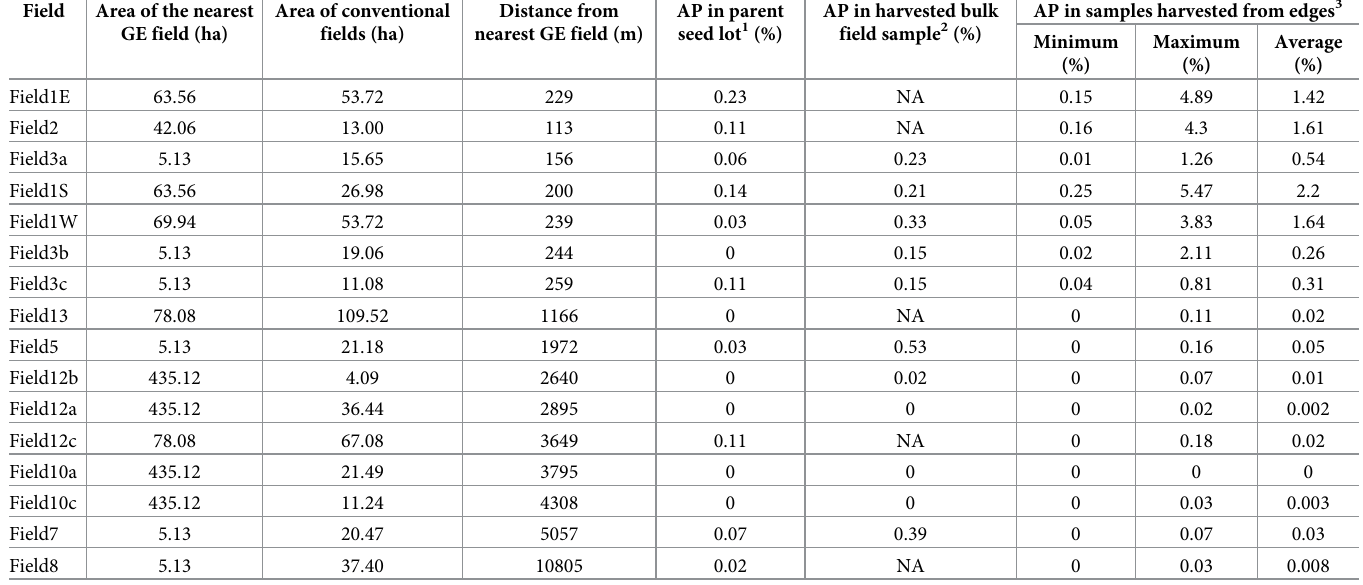
1 Percentage of seeds with the glyphosate resistance gene in samples taken from parent seed lot. 2 Percentage of seeds with the glyphosate resistance gene from in samples taken harvested bulk field lot. 3 Percentage of seeds with the glyphosate resistance gene in samples taken from field